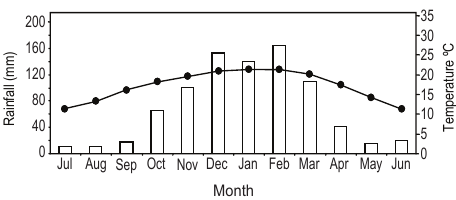
Fig. 2. Climate of the study